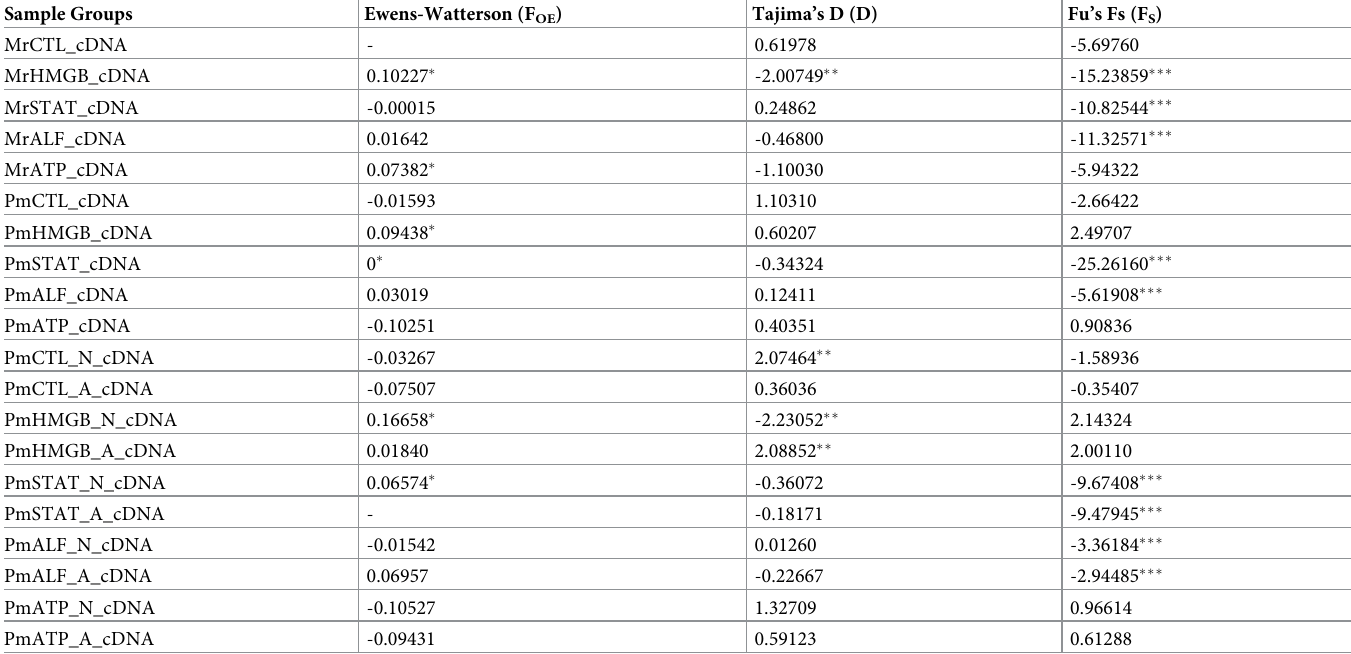
Table 2. Neutrality test using Arlequin software. Sample